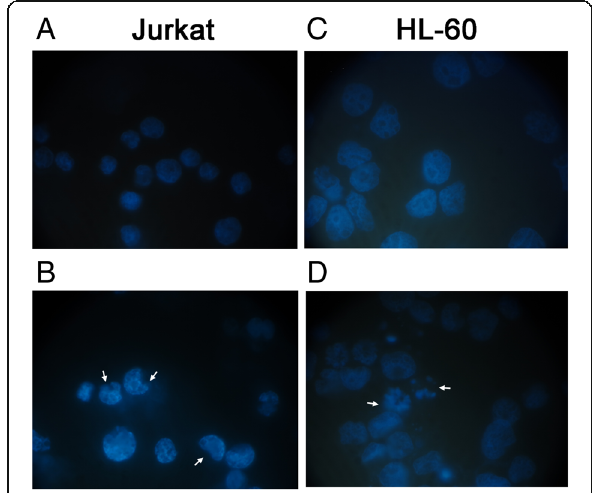
Fig. 4 Fluorescence microscopy analysis of Jurkat and HL-60 after MG treatment. Nuclear condensation and fragmentation associated to apoptotic process on Jurkat and HL-60 cells was evaluated by fluorescence microscopy at 100x magnification after 24 h of 250 μ g/ mL MG treatment ( b , d ) respect to control culture ( a , c ). White arrows indicate condensed and/or fragmented nuclei as marker of